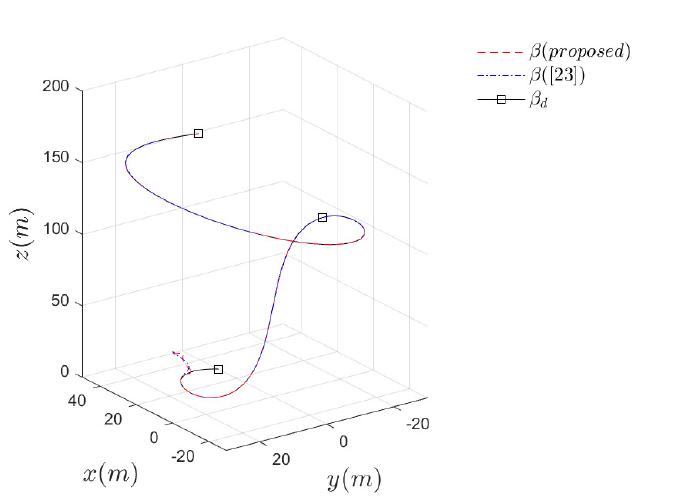
Figure 2. Comparison of tracking results of the proposed approach and the previous approach [23] in three-dimensional space for Scenario 1.